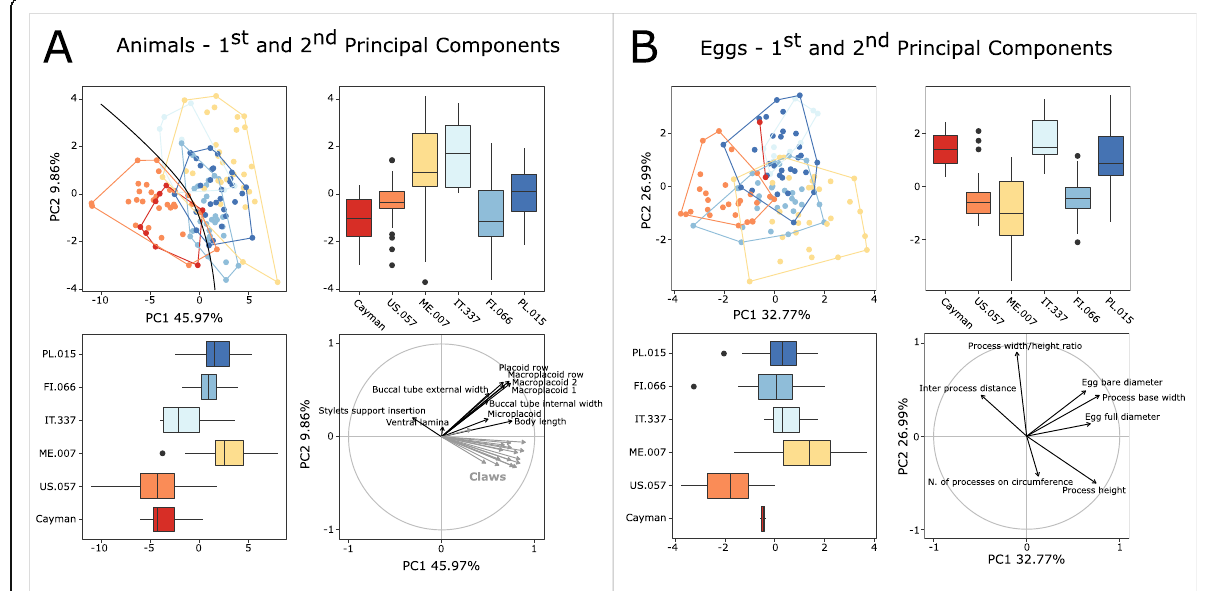
Fig. 2 Results of PCA of animal pt indices and egg raw measurements. a Animal pt indices, 1 st and 2 nd Principal Components; b Egg measurements, 1 st and 2 nd Principal Components; Top-left quadrants: score scatterplots; Top-right and bottom-left quadrants: boxplots of single component scores; bottom-right: loading plot